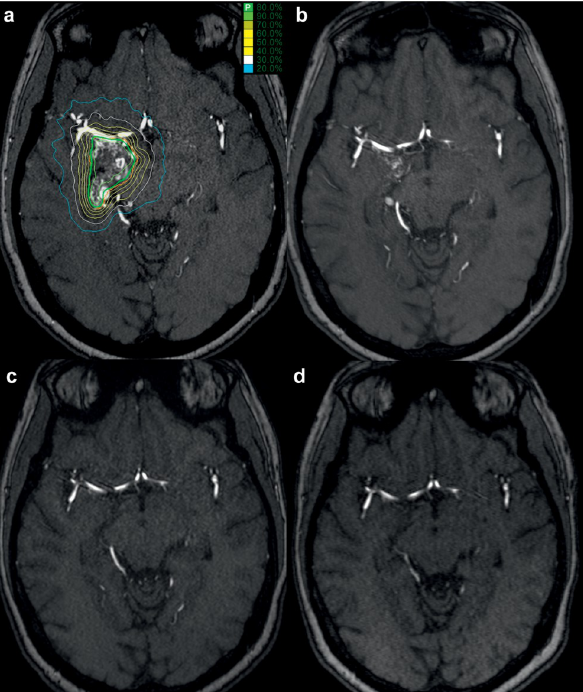
Fig 2. Exemplary obliteration process after CyberKnife radiosurgery. An example of the obliteration process for one patient with Spetzler-Martin grade IV arteriovenous malformation (AVM). The images show the CT scan with the CyberKnife treatment plan (red: target, green: prescribed isodose) a MR angiography (a), the MR angiography scans 8 months after treatment showing partial obliteration (b), and MR angiography scans of the same area two years (c) and five years (d) after radiosurgery, demonstrating complete obliteration of the AVM.